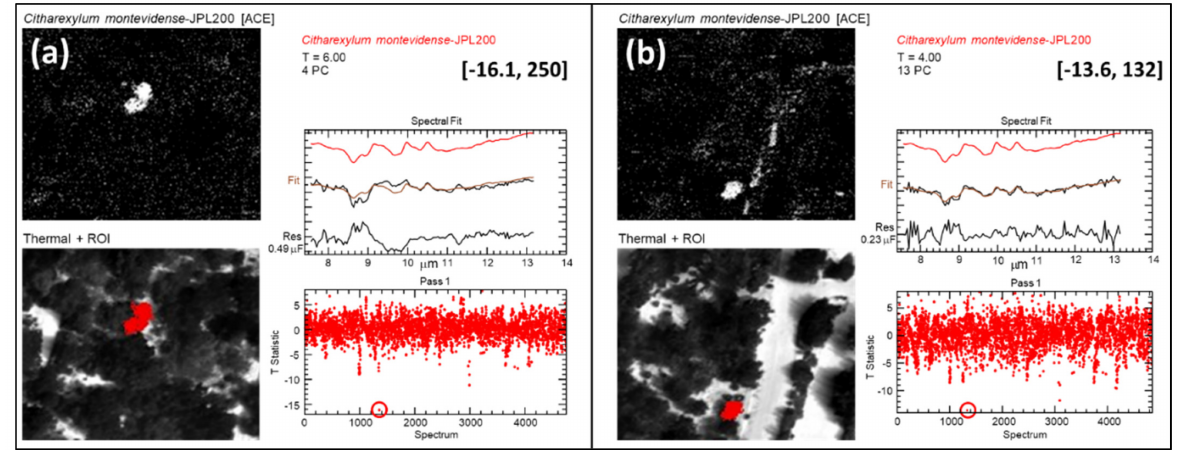
Figure 16. Specimens of Chionanthus pygmaeus mis-ID’d by the Citharexylum montevidense filter: ( a ) closely spaced stand of three trees, ( b ) single specimen.